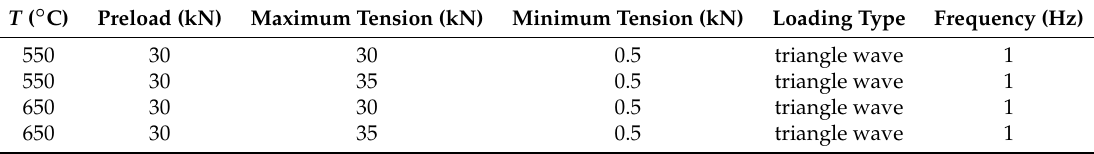
Table 3. Loading parameters of the fatigue test.